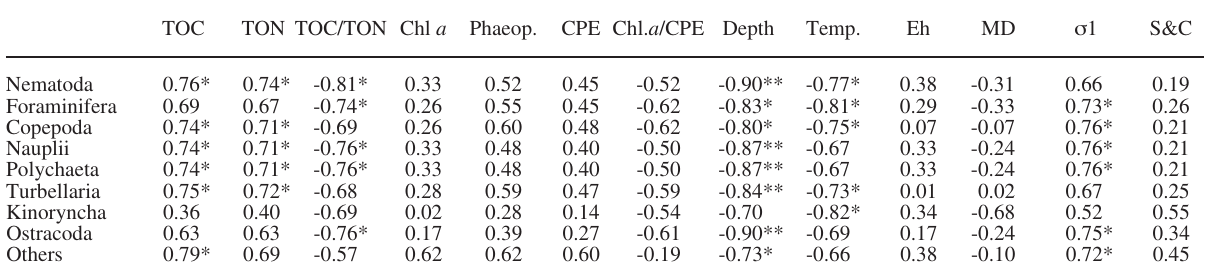
Table 3. – spearman correlation coefficient between environmental variables and meiobenthic groups (toC: total organic carbon; toN: total organic nitrogen; Chl a : chlorophyll a ; phaeop.: phaeopigments; Cpe: chloroplastic pigments equivalent; temp.: sediment temperature; eh: redox potential; md: median diameter of the sediment; σ 1: sediment sorting coefficient; s&C: percentage of silt and clay). toC